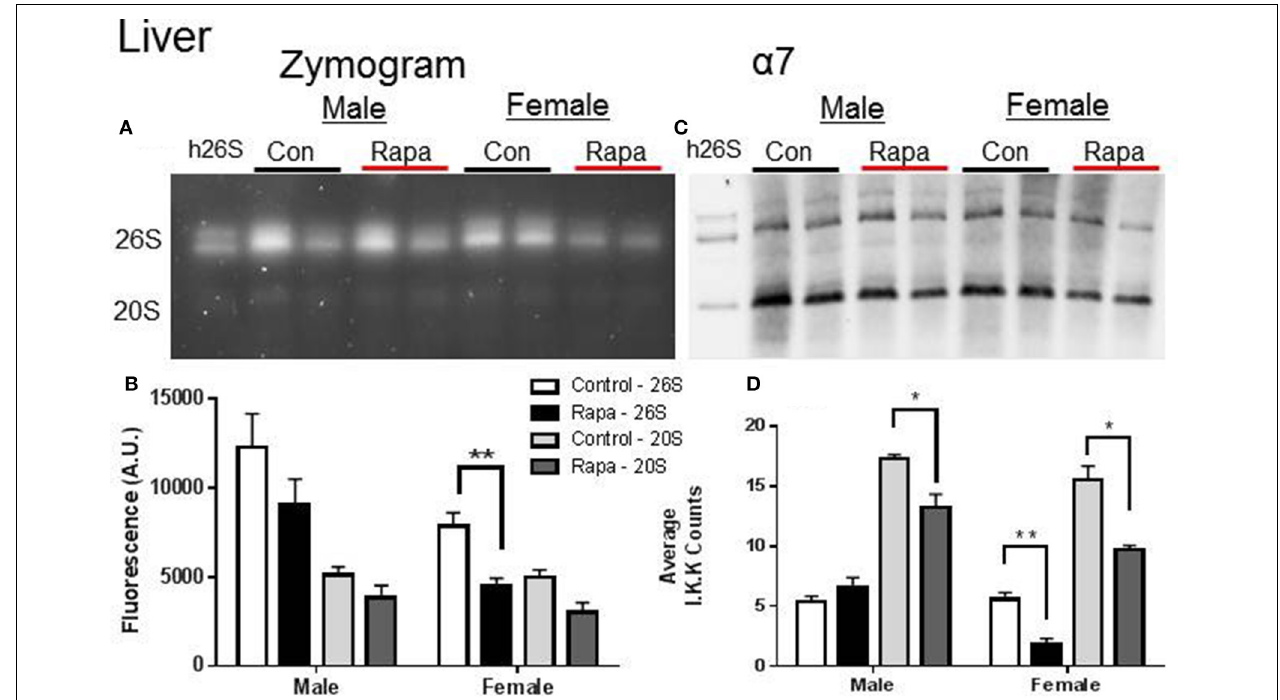
FIGURE 3 | Liver Lysates revealed potential rapamycin-dependent declines in proteasome activity. (A) Representative zymogram of Chymotrypsin-like (ChTL) proteasome activity after native gel electrophoresis of 50 μ g of liver lysate from control and rapamycin-treated old male and female animals. (B) Quantitation of zymogram showed that there was a treatement-induced decrease in